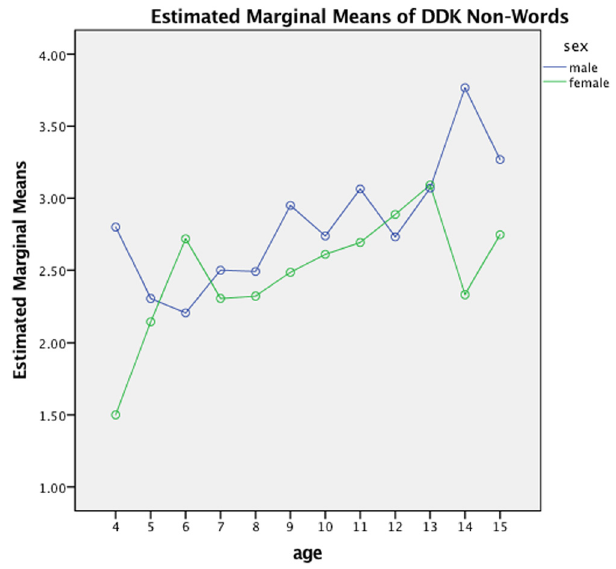
Figure 7: Age and gender e ff ects in mean total scores of non - word stimuli repetition per